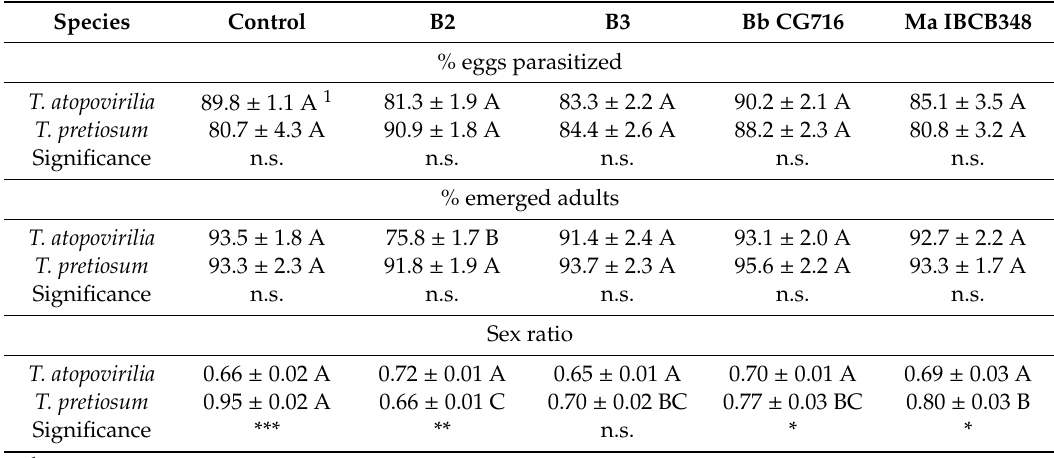
Table 2. Biological parameters (% eggs parasitized, % emerged adults and o ff spring sex ratio) of Trichogramma atopovirilia and Trichogramma pretiosum individuals emerged from Duponchelia fovealis eggs sprayed with Beauveria bassiana strains (B2 and B3) and commercial bioinsecticides (Bb CG716 and